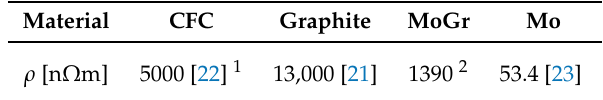
Table 2. Summary of CFC, graphite, MoGr and Mo electrical resistivity at DC assumed in beam stability computations (for anisotropic materials the resistivity is considered on the beam direction).